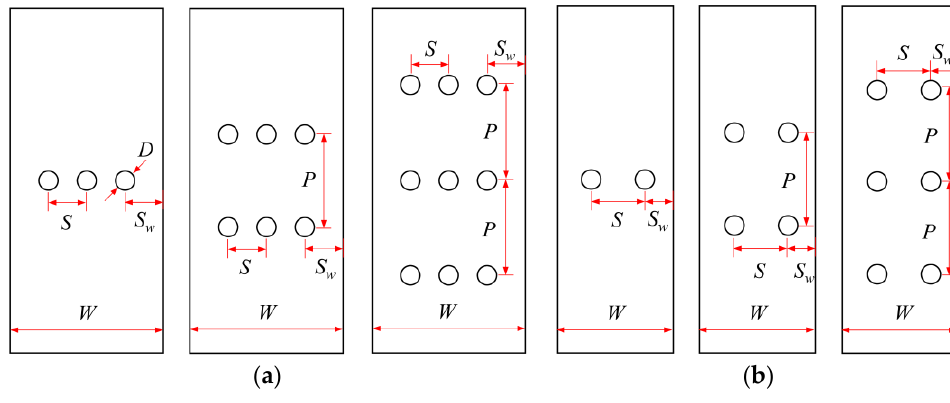
Figure 1. Multiple-hole FML specimens adopted in ( a ) [37] and ( b ) [38]. Table 1. Geometrical parameters of specimens in [37] and [38].